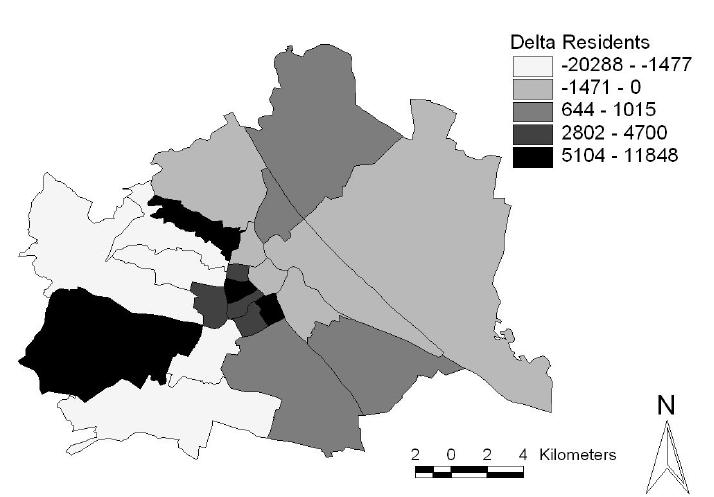
Figure 10: Changes in residential development for 30 years constrained optimisation strategy – do nothing Vienna